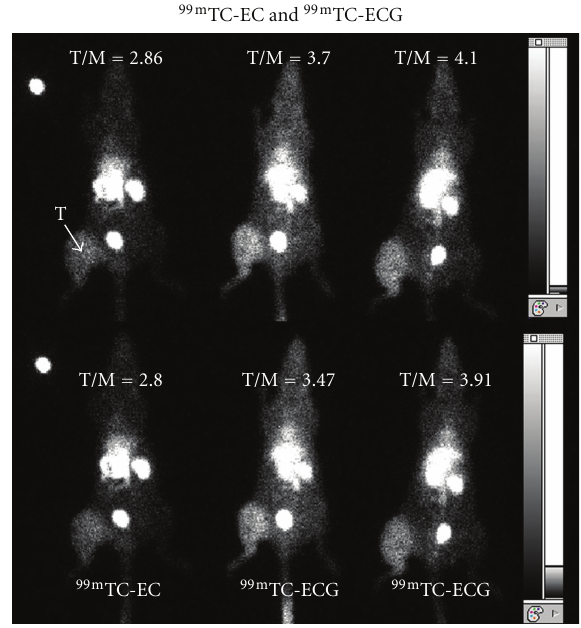
Figure 7: Planar scintigraphy of 99m Tc-EC (left) and 99m Tc-ECG (300 μ Ci/rat, iv, acquired 500,000 count) (middle and right) in mesothelioma-bearing rats. The numbers are tumor-to-muscle count density ratios at 1hr (upper panel) and 2hrs (lower panel). T: